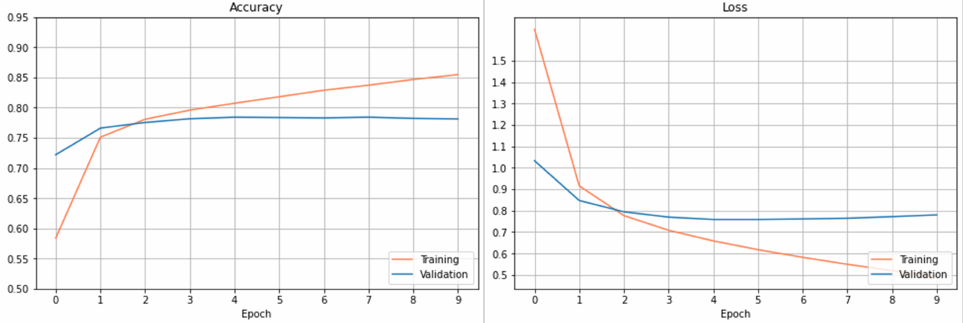
Figure 5. Training and validation results using the transformers-based architecture. ( Left ): Accuracy vs. epochs; ( Right ): Loss vs.